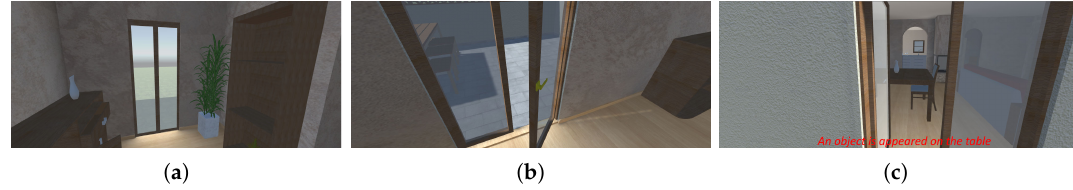
Figure 7. Example of steps tp be performed during the third exercise. The patient moves toward the window ( a ), then he opens the latter to move outside ( b ). Finally, the system prompts the istructions for the exercise and the patient moves back to the living room ( c